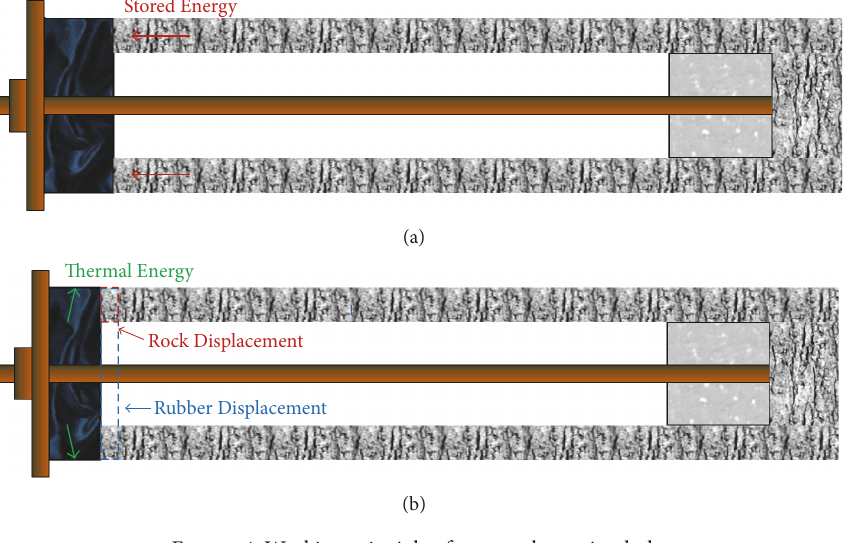
Figure 4: Working principle of energy absorption bolt.